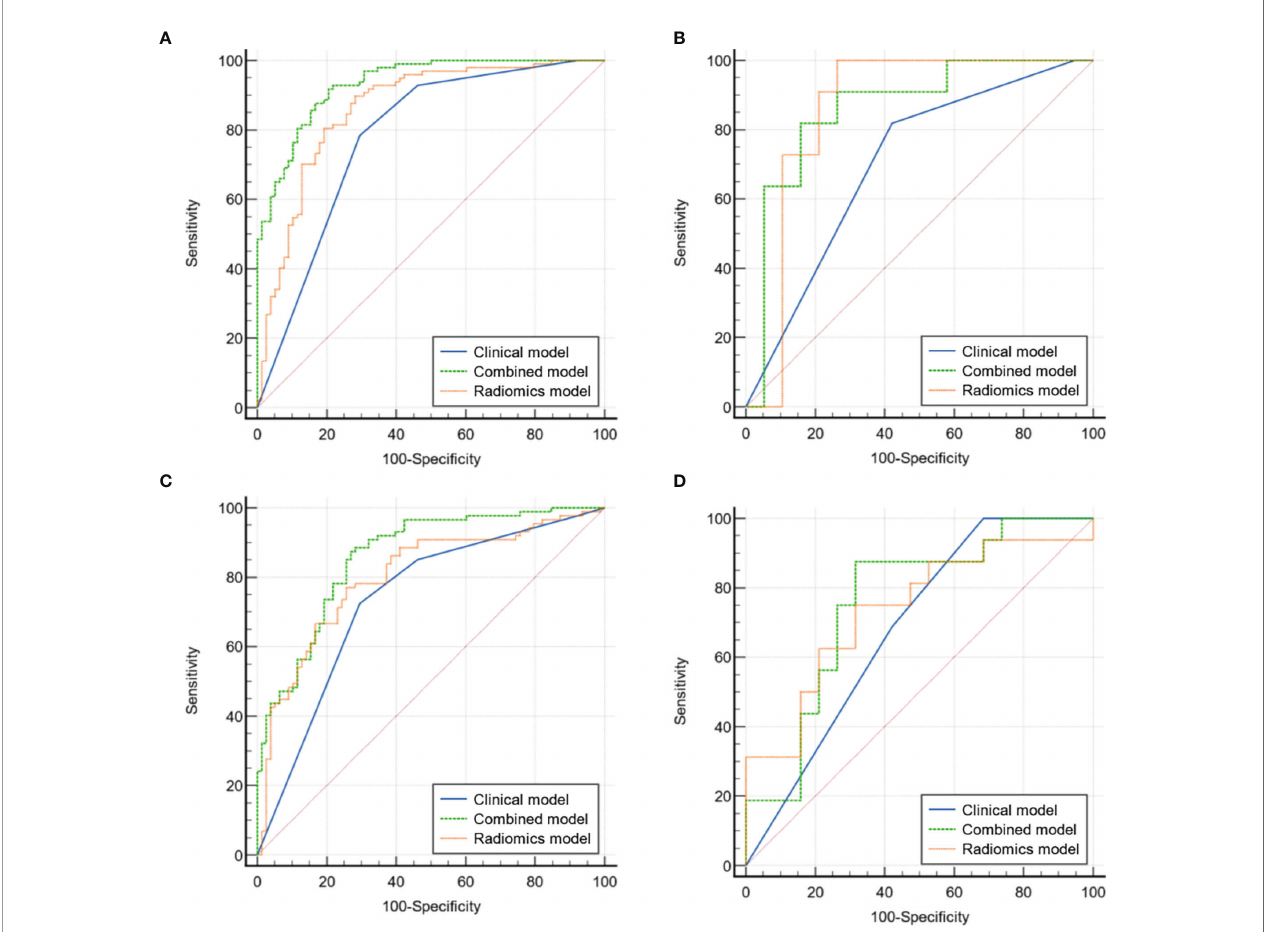
FIGURE 3 | Comparison of ROC curves for the validation of clinical, radiomics, and integrated models for predicting hpIDC-P ( A internal, B external) and lpIDC-P ( C internal, D